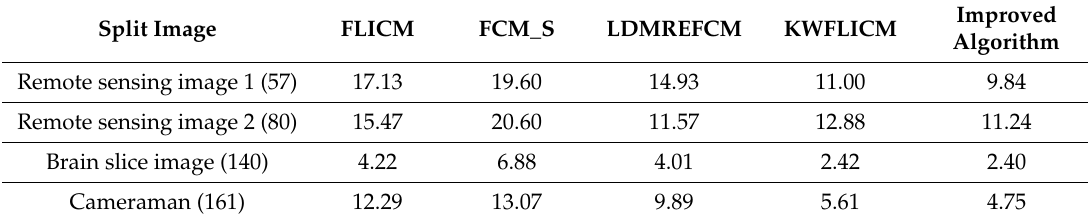
Table 2. Comparisons of the misclassification rate (MCR) (%) against Gaussian noise using di ff erent algorithms.